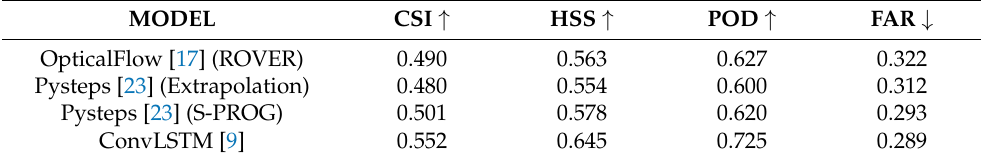
Table 6. Skill score at R > 20 dBZ (two-hour